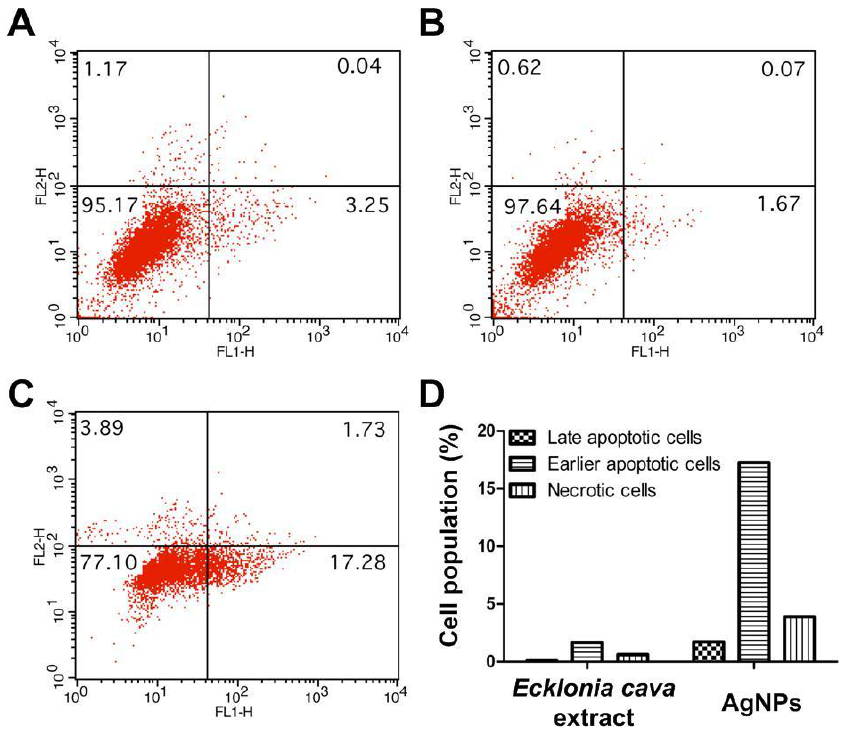
Figure 11. Annexin/PI staining of: ( A ) untreated HeLa cells; ( B ) HeLa cells treated with 250 µg/mL of Ecklonia cava extracts; ( C ) HeLa cells treated with 250 µg/mL of biosynthesized AgNPs; and ( D ) relative cell population of HeLa cells after treatment with Ecklonia cava extracts and biosynthesized AgNPs.